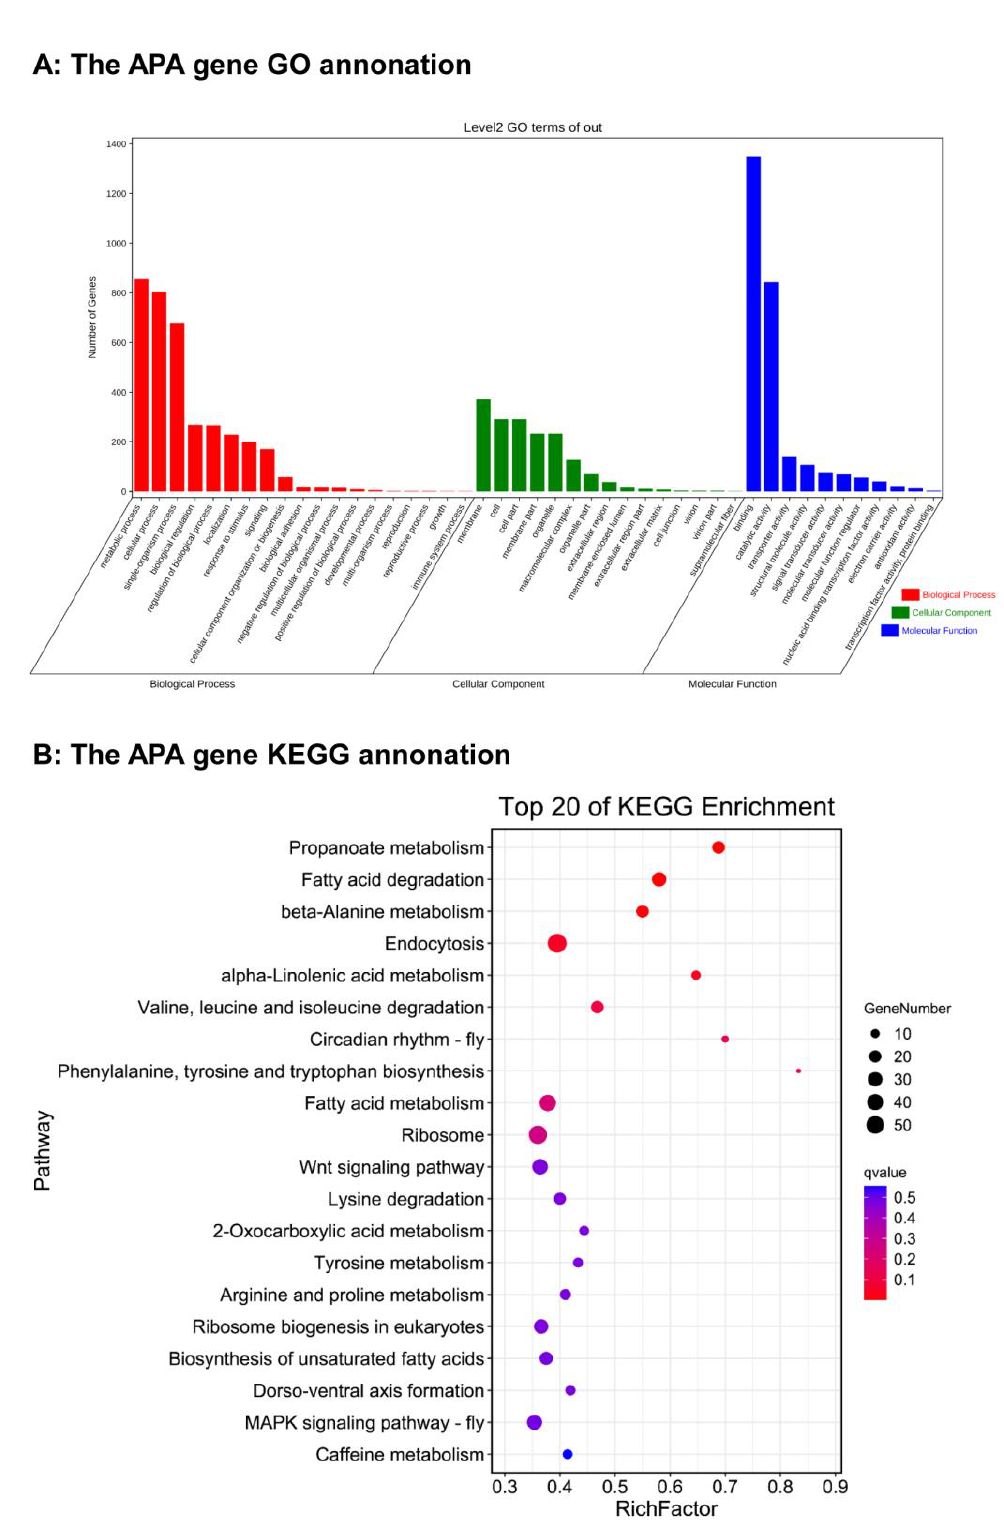
Figure 4. The alternative polyadenylation gene annotation. ( A ) The genes with 2 or more polyadeny- lation signals were applied for enrichment tests. ( B ) KEGG enrichment of genes with two or more PAS pathways is shown in a scatter diagram. The top 20 pathway names are represented on the Y -axis, and the X -axis shows the proportion of annotated genes to all annotated genes in a pathway. The colors of dots represent the different value. Red is the lowest value and blue is the highest value The size of each dot represents the gene